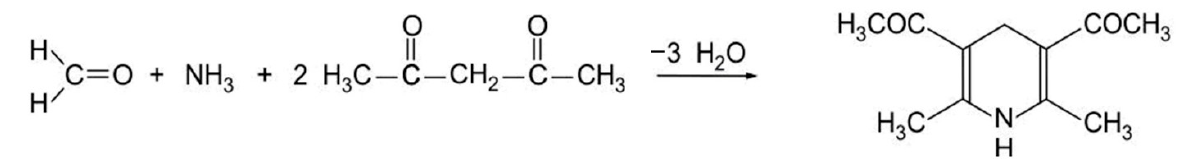
Figure 3. Reaction for formaldehyde determination.